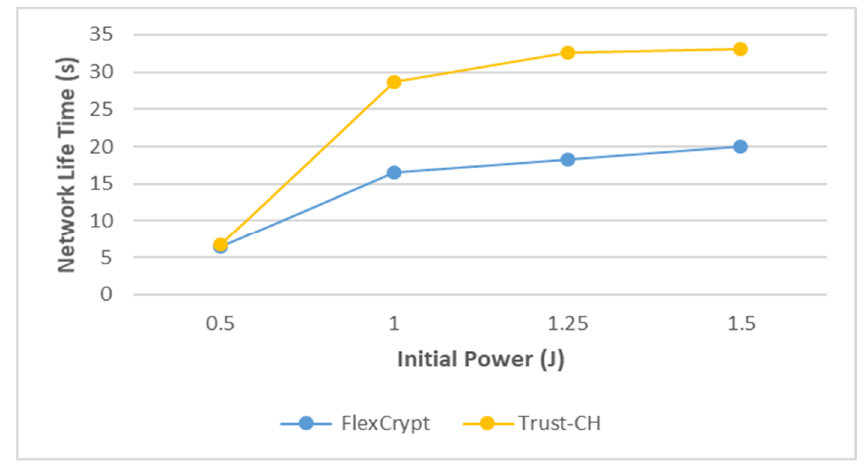
Figure 11. Comparison of Trust-CH and FlexCrypt on network lifetime.